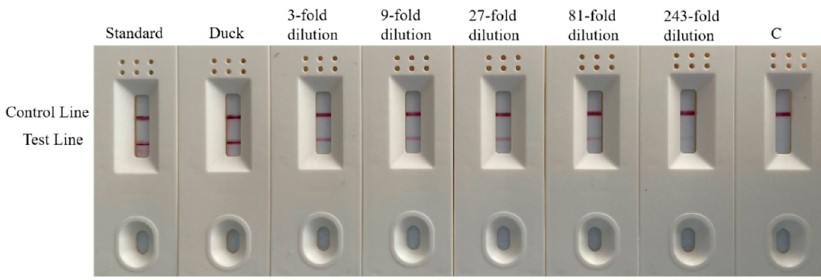
Figure 11. Test results of strip sensitivity. Channel C is blank control.